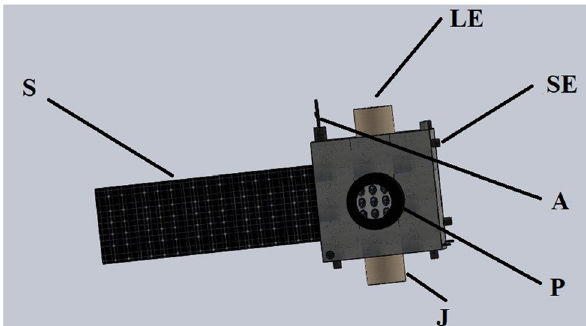
Figure 2: Front view of the micro/nanosatellite. A: communication antenna; SE: small - thrust engine; LE: large - thrust engine; P: remote sensing payload; J: joint connection mechanism ( functions as a connection under normal states and transforms into a large - thrust engine when removing ) ; and S: solar